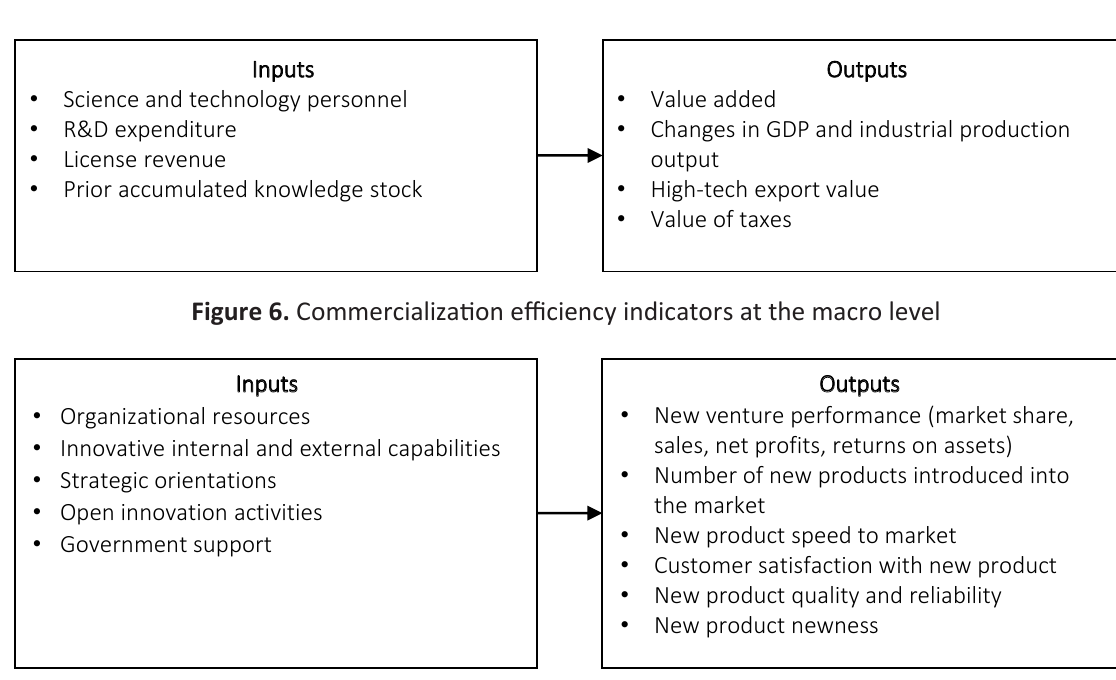
Figure 7. Commercialization efficiency indicators at the company level